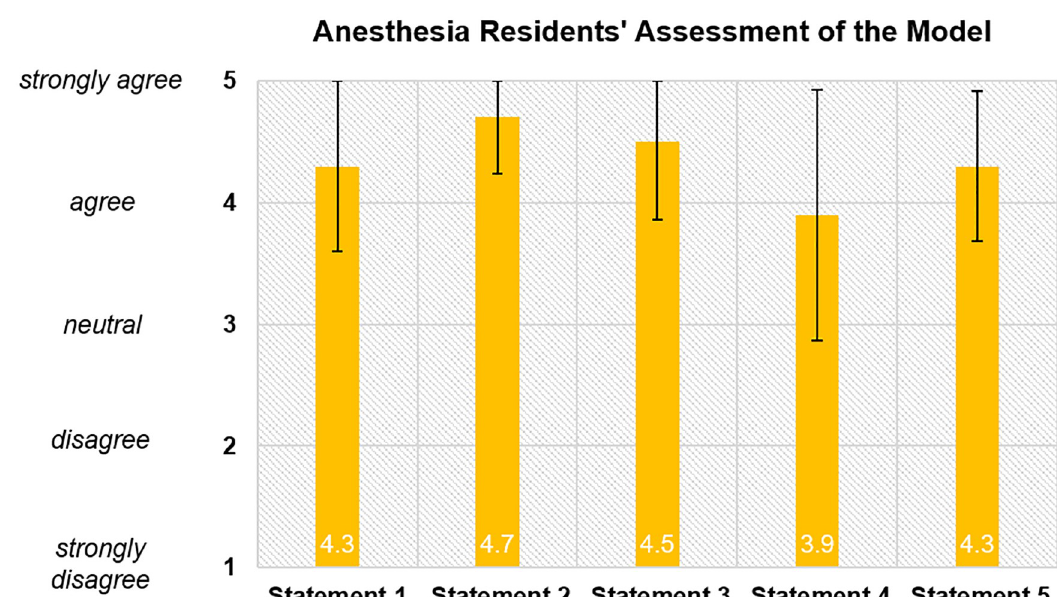
Fig 5. Anesthesia residents’ assessment of the model. Statement 1. The thoracic epidural model helps me feel different tissue layers of soft tissue, bone, ligamentum flavum. Statement 2. The thoracic epidural model helps me visualize location of the needle tip with redirection at skin surface. Statement 3. The thoracic epidural model helps me improve manual dexterity for epidural needle placement. Statement 4. The thoracic epidural model helps me learn the feeling of loss of resistance. Statement 5. The thoracic epidural model helps me prepare for epidural placement in a patient.